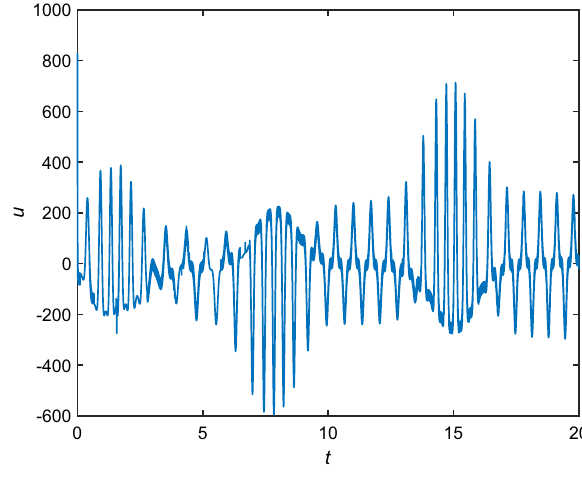
Fig. 3 The synchronization errors